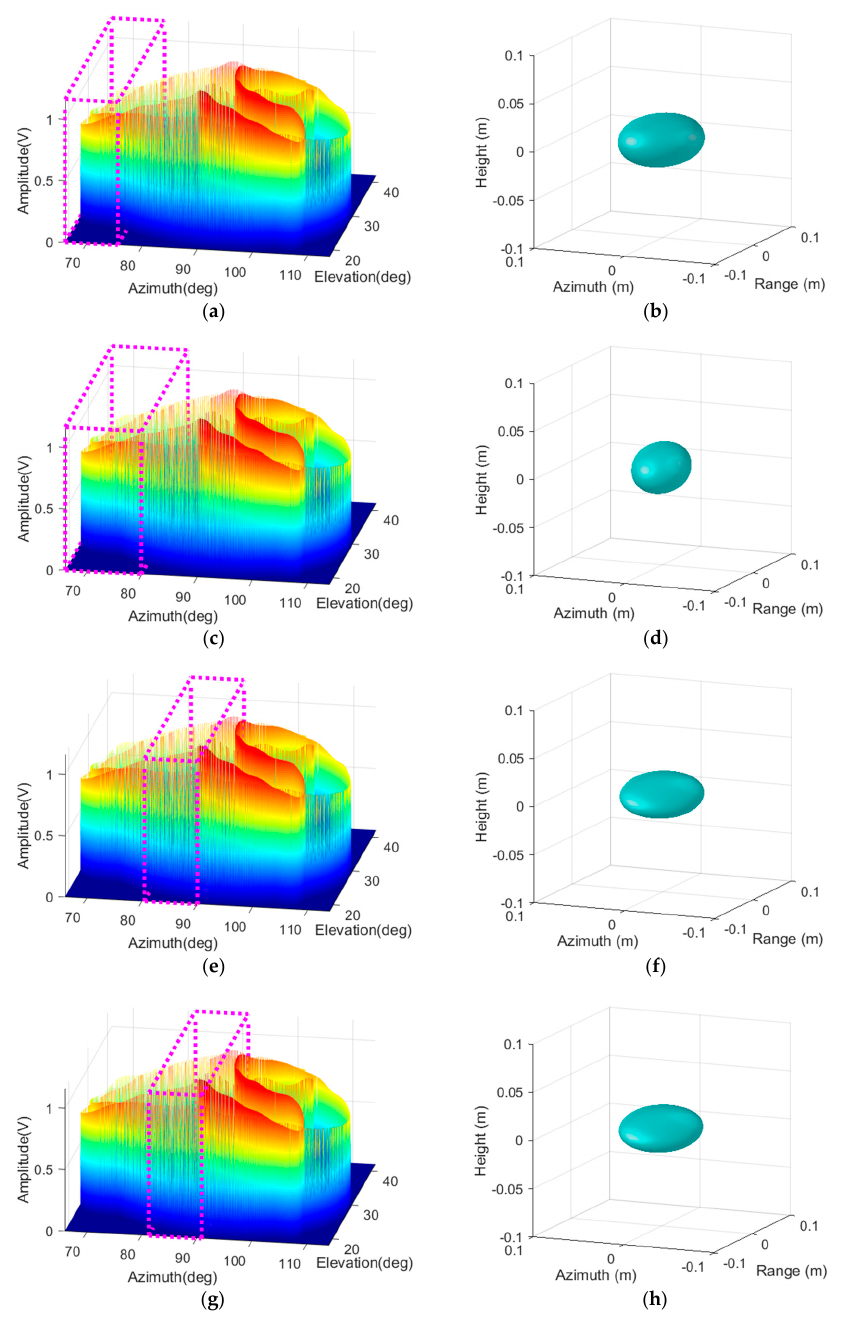
Figure 9. Target scattering amplitudes and 3-D imaging results of different sub-apertures obtained by different sub-aperture partitioning methods. ( a , e ) and ( b , f ) show target scattering amplitudes and 3-D imaging results of sub-aperture 1 and sub-aperture 4 obtained by the equal-interval sub-aperture partitioning method, respectively; ( c , g ) and ( d , h ) show target scattering amplitudes and 3-D imaging results of sub-aperture 1 and sub-aperture 4 obtained by the non-uniform sub-aperture partitioning method, respectively.